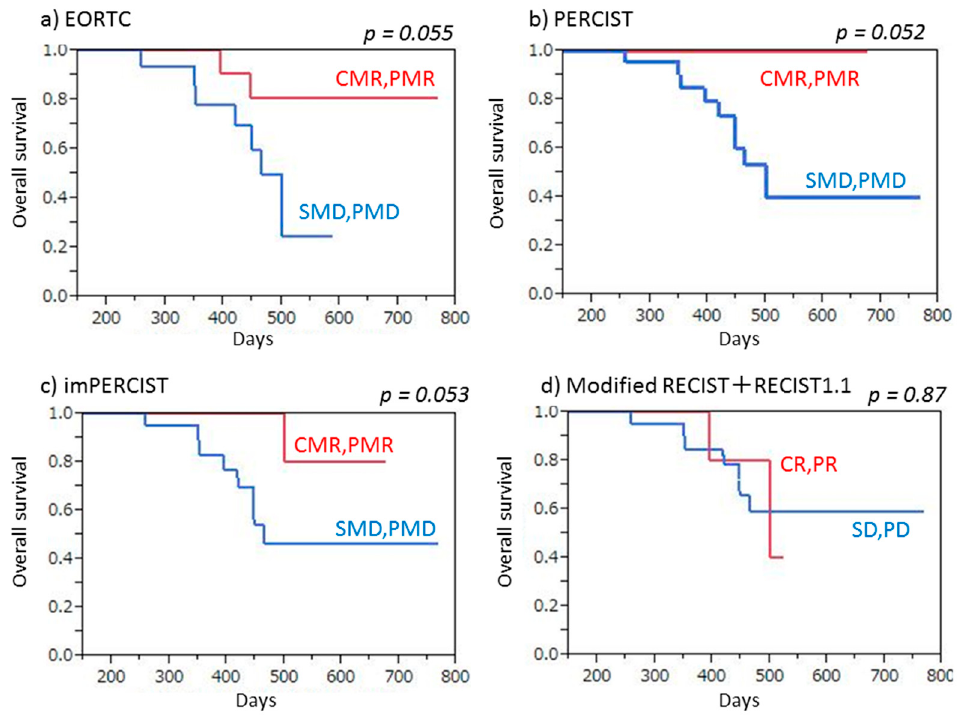
Figure 6. Overall survival (OS) of malignant pleural mesothelioma patients treated by nivolumab therapy, with and without response. ( a ) EORTC demonstrated that responders (CMR/PMR) tended to show longer OS than non-responders (SMD/PMD), without a significant difference ( p = 0.055). ( b ) PERCIST demonstrated that responders (CMR/PMR) tended to show longer OS than non-responders (SMD/PMD), without a significant difference ( p = 0.052). ( c ) imPERCIST demonstrated that responders (CMR/PMR) tended to show longer OS than non-responders (SMD/PMD), without a significant difference ( p = 0.053). ( d ) Combined modified RECIST and RECIST 1.1 demonstrated no significant difference for OS between responders (CR/PR) and non-responders (SD/PD) ( p = 0.87).